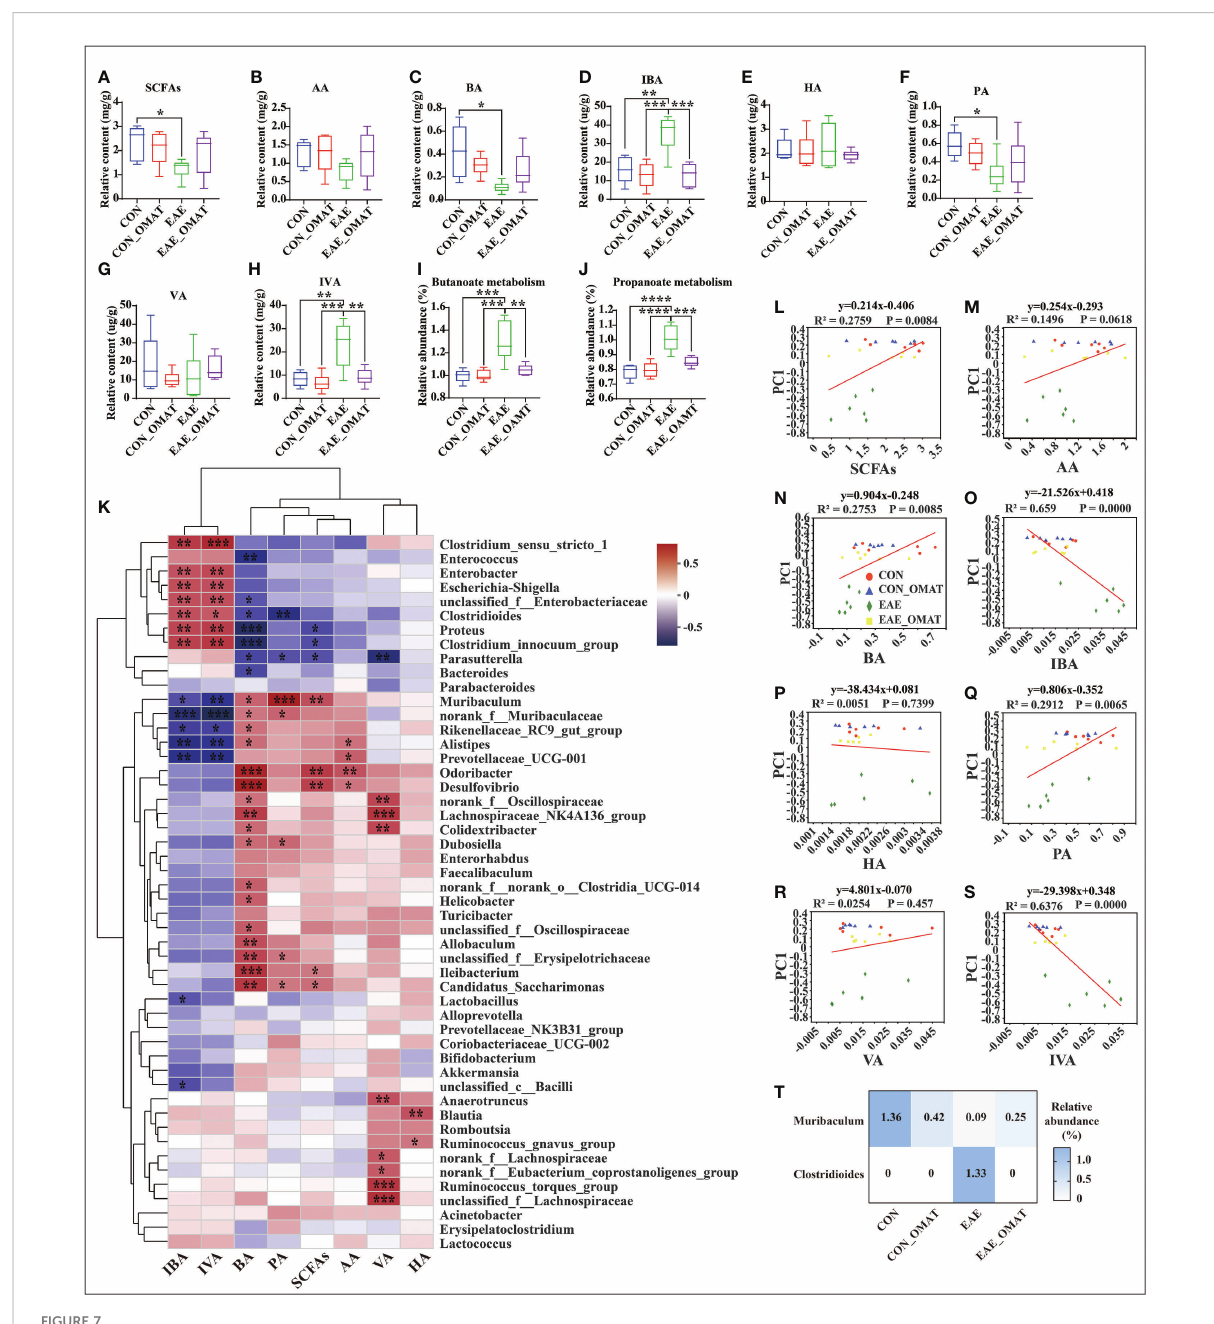
FIGURE 7 Effect of oxymatrine on the gut microbiota and the concentration of short-chain fatty acids (n = 6 in each group). (A – I) The concentration of SCFAs (A) , acetic acid (AA) (B) , butyrate acid (BA) (C) , isobutyrate acid (IBA) (D) , hexanoic acid (HA) (E) , propionic acid (PA) (F) , valeric acid (VA) (G) , and isovaleric acid (IVA) (H) in the feces of the four mice groups. (I, J) KEGG orthologs (KOs) are associated with Butyrate metabolism (I) and Propionate metabolism (J) . Correlation heatmap diagram of the concentration of short-chain fatty acids (SCFAs) and the relative abundance of gut microbes belonging to a different genus (K) . (L – S) Linear rank regression analysis of the relationship between the gut microbiome and the concentration of SCFAs (M) , acetic acid (N) , butyrate acid (O) , isobutyrate acid (P) , hexanoic acid (Q) , propionic acid (R) , valeric acid (S) , isovaleric acid (T) in the feces of the four mice groups. (T) Relative abundance of Clostridioides and Muribaculum in the four mice groups. The P values for (A – H) were derived from the LSD-t test. In (I-J) and (T) , the P value was determined based on Wilcoxon rank-sum test with the Benjamini – Hochberg method. In (K-S) , the relation between the abundance of microbial genera/OTUs and the concentration SFCAs was assessed using Spearman ’ s rank correlation coef fi cient. Data are expressed as the mean ± SD and statistical differences are represented by *, P < 0.05, **, P < 0.01, ***, P < 0.001, and ****, P <